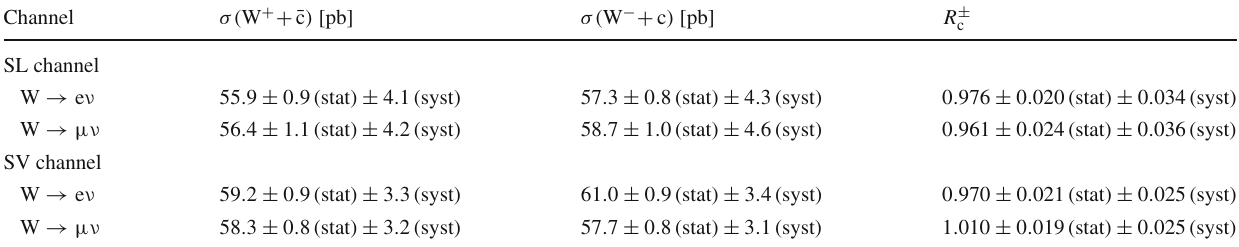
Table 5 Measured production cross sections σ( W + +¯ c ) , σ( W − + c ) , and their ratio, R ± c , in the SL (upper) and SV (lower) channels for the electron and muon W boson decay modes